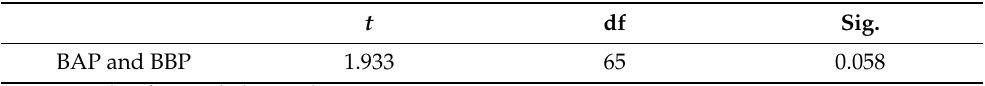
Paired t -test results for the amounts of C stored both aboveground (BAP) and belowground